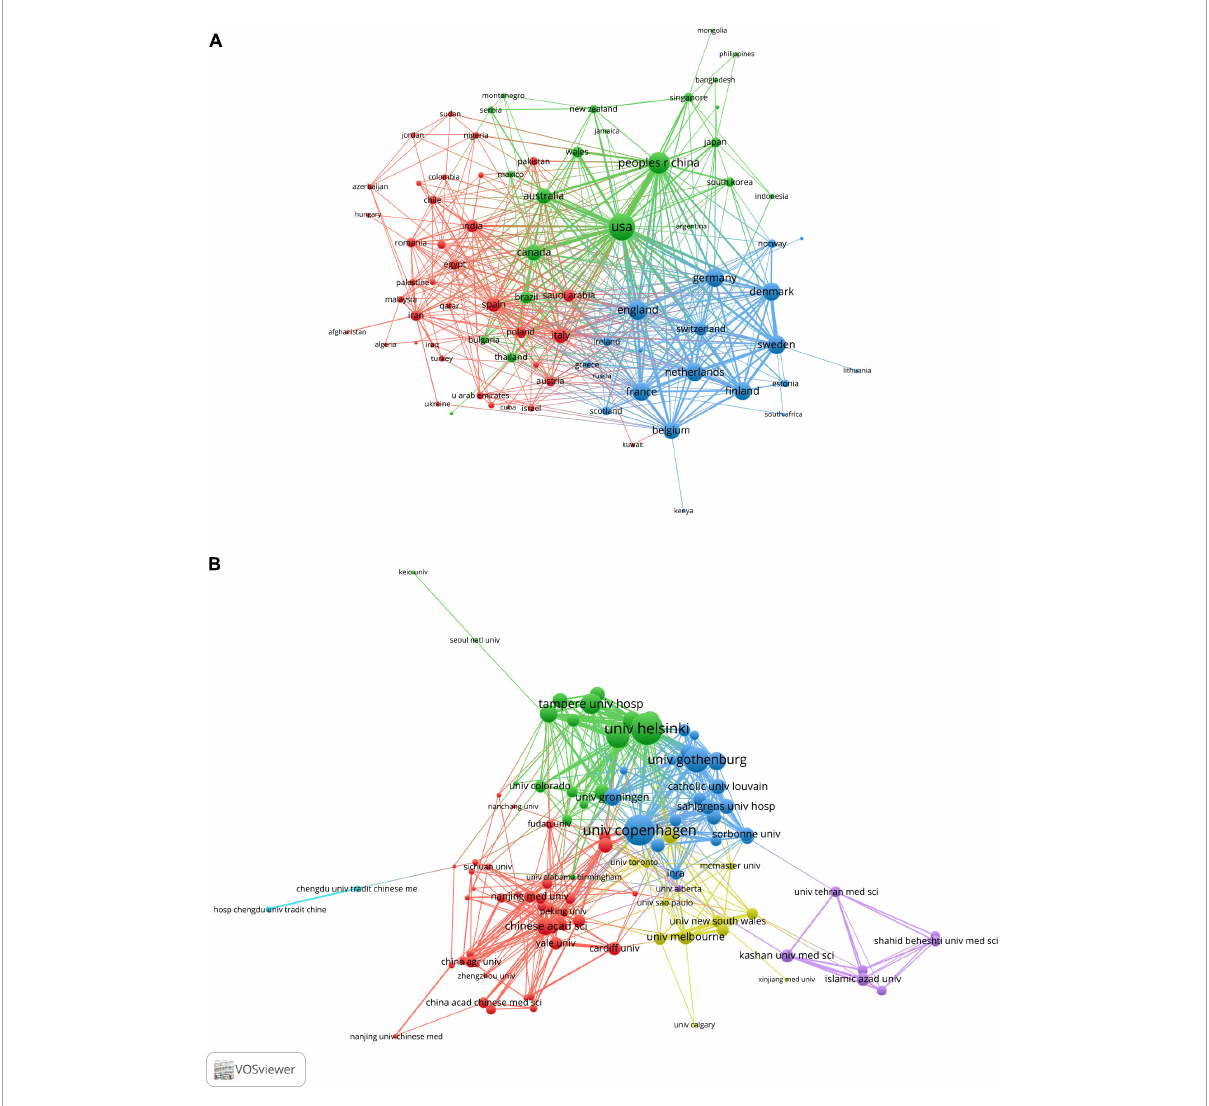
FIGURE3 VOSviewer network visualization map of countries/regions and academic collaboration in the “gut microbiota and diabetes” area. (A) Collaboration network map of the most productive countries. (B) Collaboration network map of the most productive research institutions.